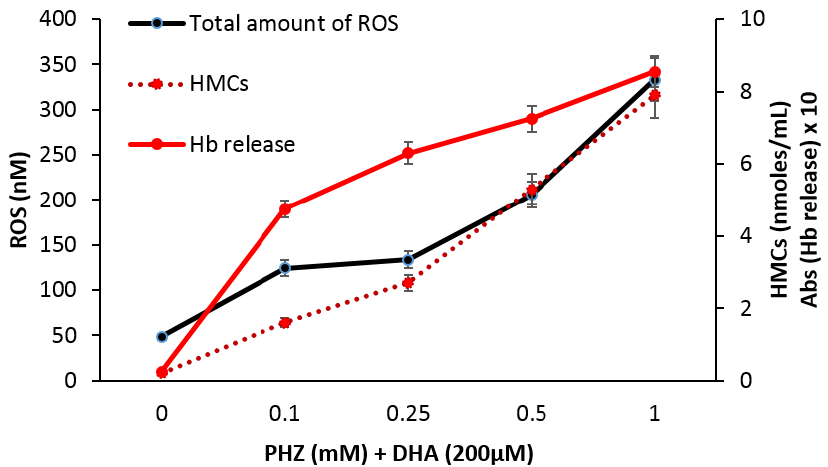
Figure 4. Hemichromes (HMCs) accumulation and total amount of reactive species (O 2•− + H 2 O 2 ) in RBCs treated with DHA (200 μΜ) and different concentrations (0.1, 0.25, 0.5, 1 mM) of phenylhydrazine (PHZ).